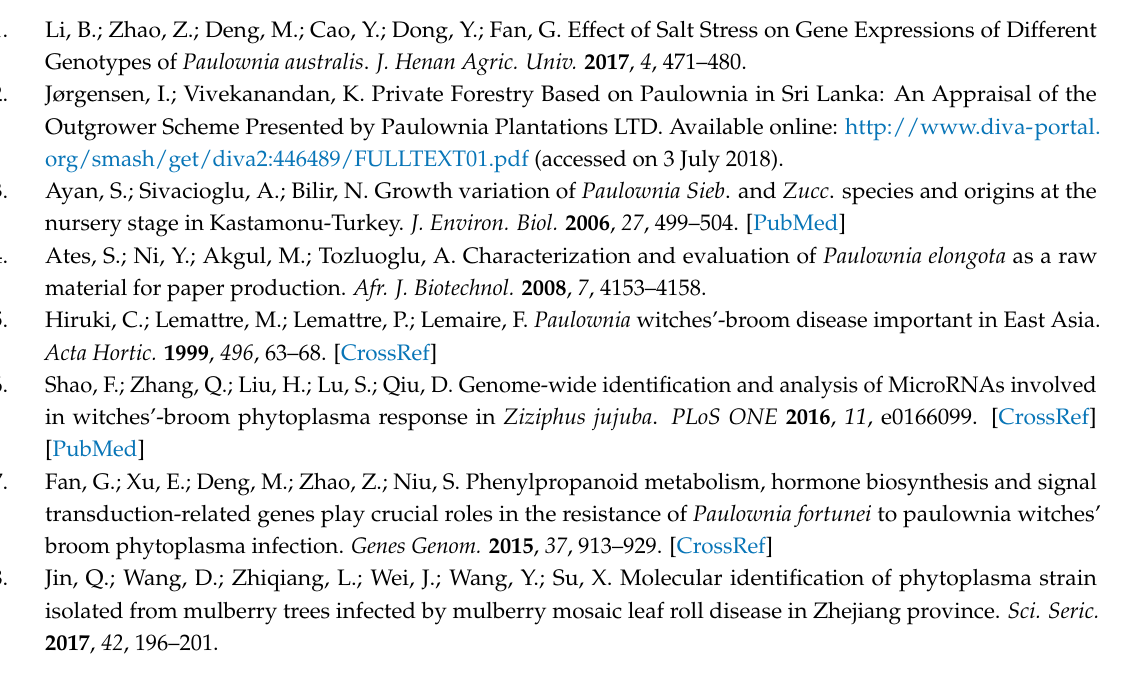
Table S1: The results of DEGs of transcriptome sequencing, Table S2: The basic statistics of the miRNA sequencing, Table S3: The results of miRNA sequencing, Table S4: The family classification of miRNAs, Table S5: The DERs in PF and PFI libraries, Table S6: The number of target genes corresponding to miRNAs, Figure S1: Boxplot of log10 (FPKM) of genes, Figure S2: Gene Ontology functional classification of the DEGs, Figure S3: Gene Ontology enrichment of the DEGs, Figure S4: KEGG annotation for the